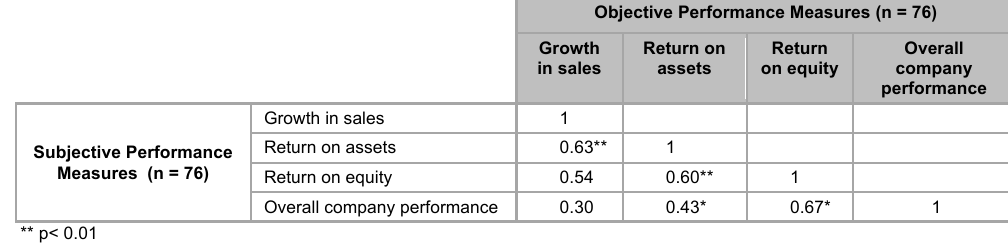
Correlations for objective and subjective variables (Pearson Coefficient)